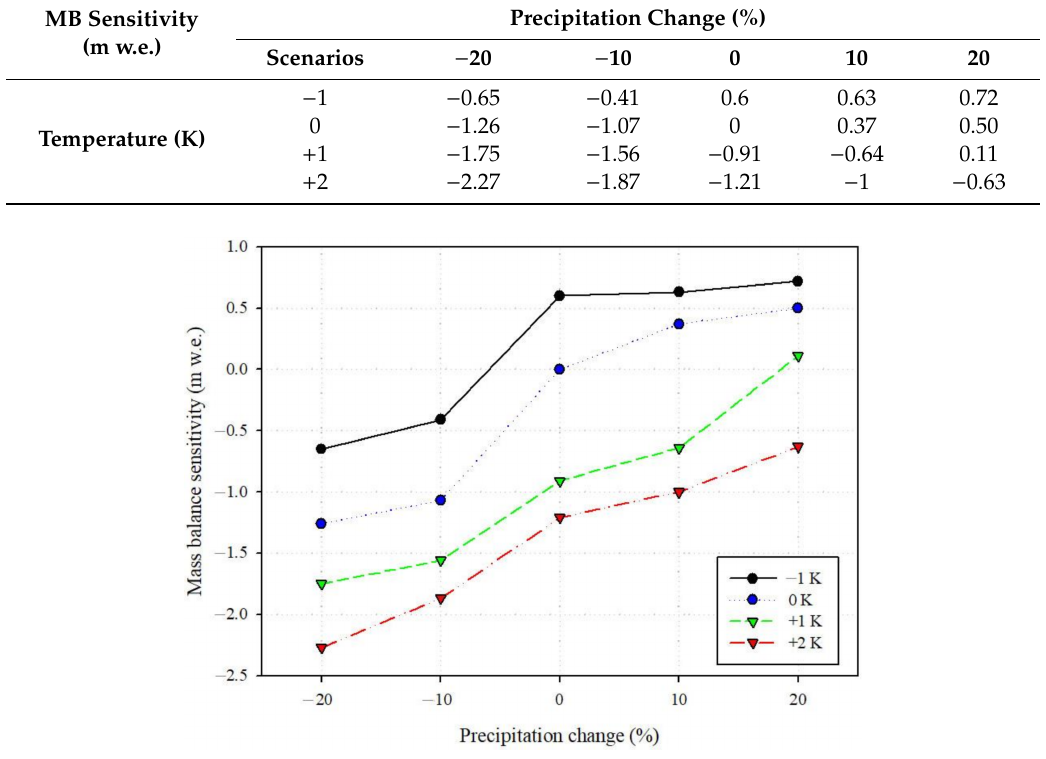
Figure 8. Mass balance sensitivity under di ff erent